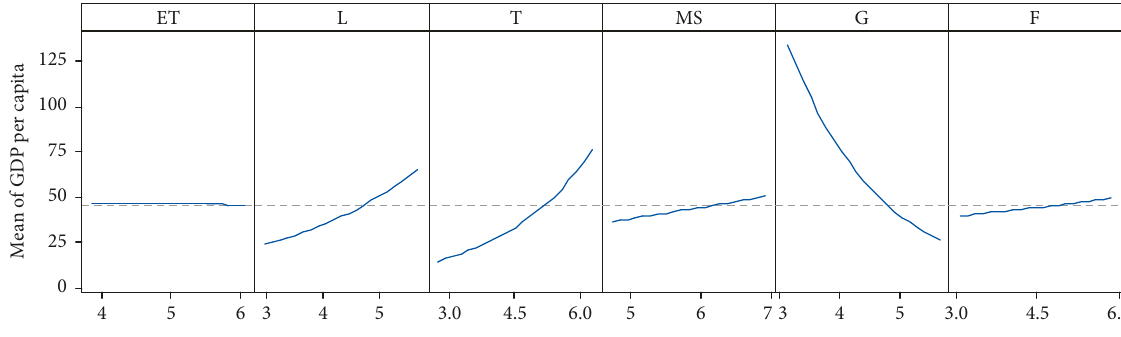
Figure 1: The main effects of factors for UGDP-PC.